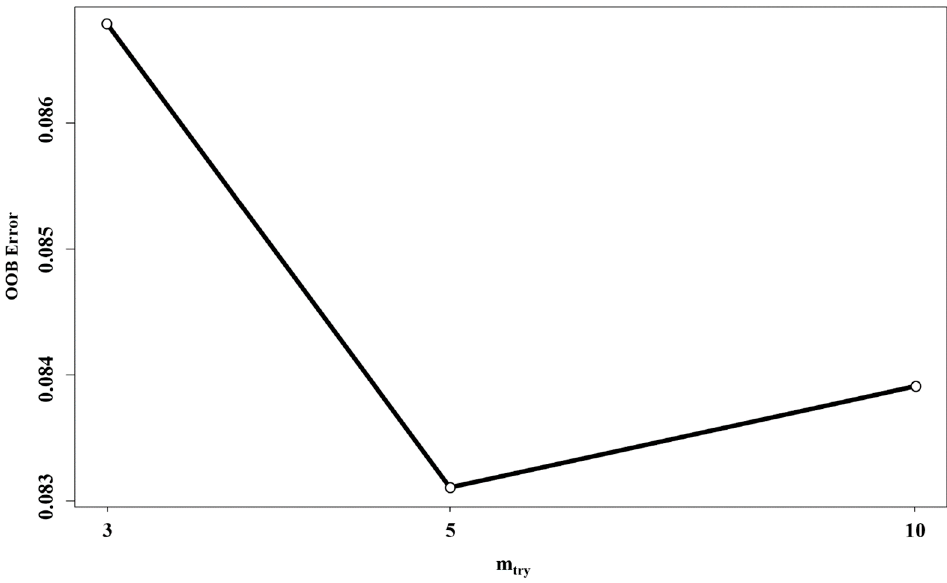
Figure A1. OOB Error of the number of RF mtry.